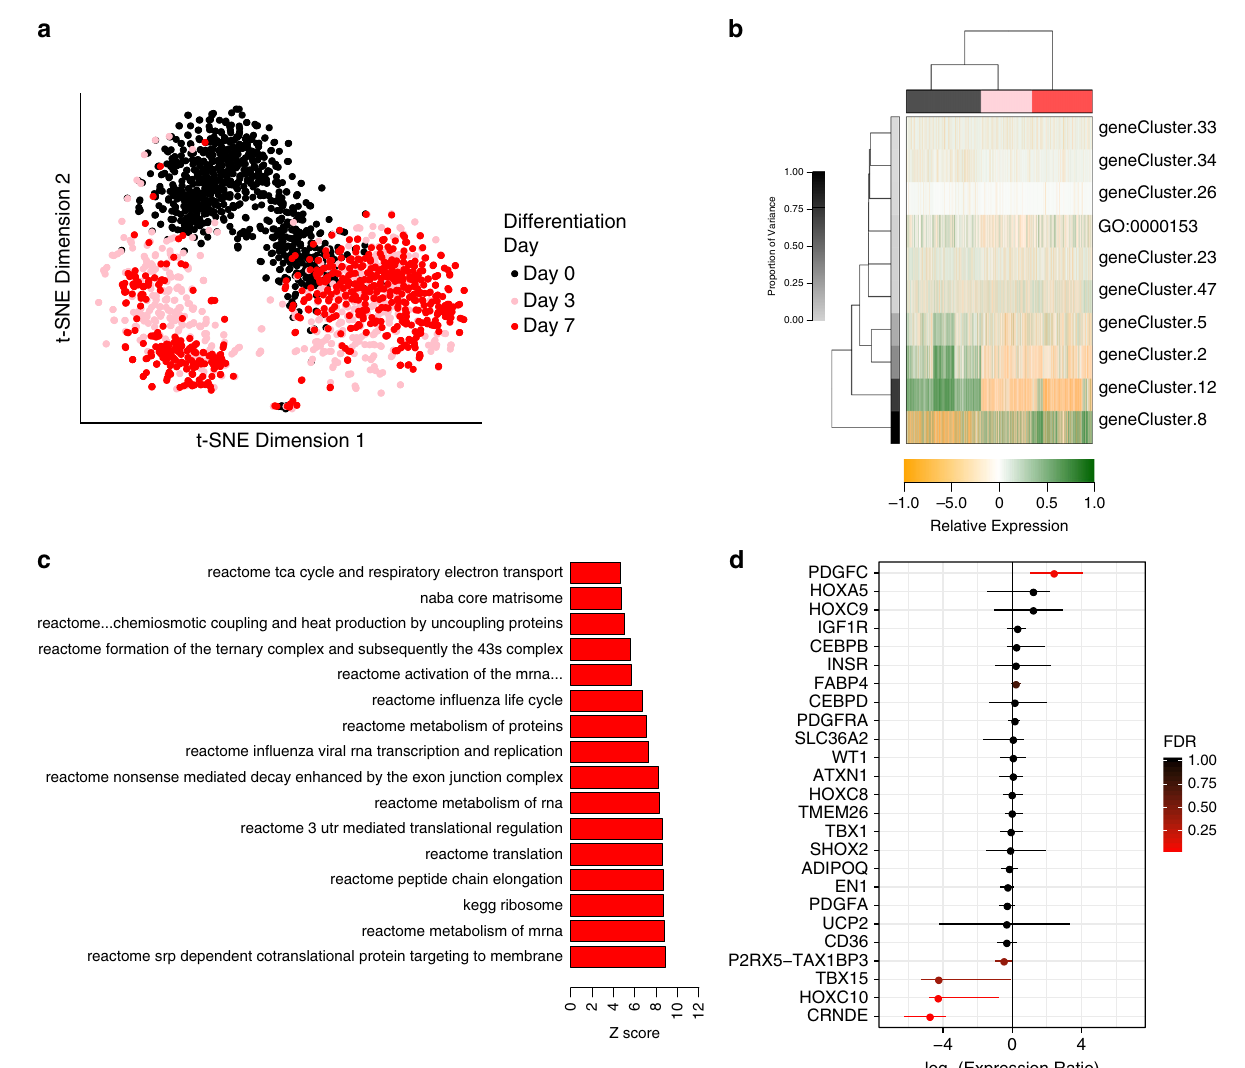
Fig. 1 PAGODA and t-SNE reveals at least two clusters in differentiating preadipocytes. a Single-cell RNA seq was performed on differentiating preadipocytes beginning at 80% con fl uency and differentiated for 7 days. PAGODA was used to determine the optimal cell clustering based on the genes driving the heterogeneity. The result was plotted by t-SNE. A total of 2092 are shown. b Single-cell expression pro fi les in were analyzed to determine the genes and pathways driving the heterogeneity. PAGODA was used to perform weighted principle component analysis on pre-de fi ned (e.g., Gene Ontology terms) and de novo gene sets. The gene sets were scored on their signi fi cance. Correlated gene sets were coalesced in order to reduce redundancy. The heatmap of the signi fi cance gene sets shows a few de novo gene sets captured major aspects (i.e., non-redundant principal components) of heterogeneity. c Differential gene expression was performed between the left and right clusters for each day of differentiation in differentiating preadipocytes beginning at 100% con fl uency. Gene set enrichment analysis was performed on the differentially expressed genes and the top 10 up- and down-regulated pathways sorted by z-score are shown for day 7. d Differential gene expression was performed between the left and right clusters of day 7 adipocytes. The genes shown are previously-studied adipocyte markers for lineage or differentiation stage. For each gene, the maximum likelihood estimate and 95% con fi dence interval of the log2 expression ratio (right cluster over left cluster) is shown. The brown adipocyte markers MYF5 and UCP1 were not detected in any Cadherin-6 ( CDH6 ) and Nucleophosmin ( NPM1 ), showed dif- ferent levels of expression in cells within the same clusters, sug- gesting subclusters within both clusters A and B (Fig. 2b).